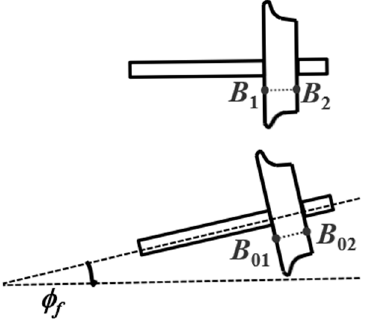
φ φ . Figure 10. Solving method of f f